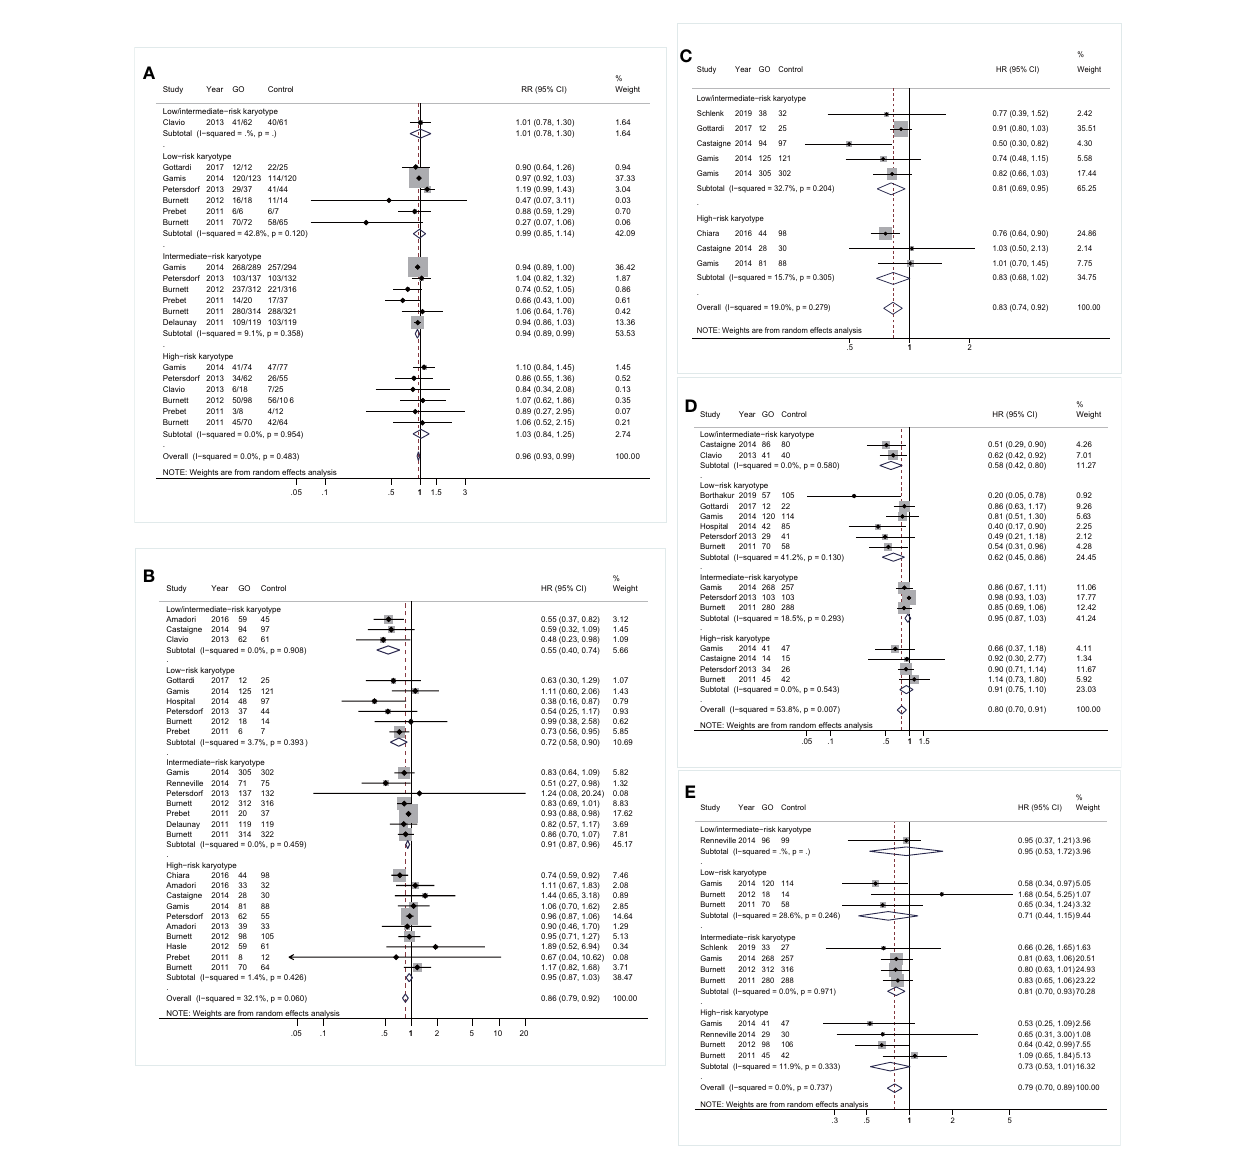
FIGURE 2 | Prognostic subgroup analyses regarding karyotype strati fi cations of AML. (A) CR. (B) OS. (C) EFS. (D) RFS. (E) CIR. The diamonds represent the overall summary RR and HR estimates with 95% CI. GO, gemtuzumab ozogamicin; AML, acute myeloid leukemia; CR, complete remission; OS, overall survival; EFS, event-free survival; RFS, relapse-free survival; CIR, cumulative incidence of relapse; RR, relative risk; HR, hazard ratio; 95% CI, 95% con fi dence